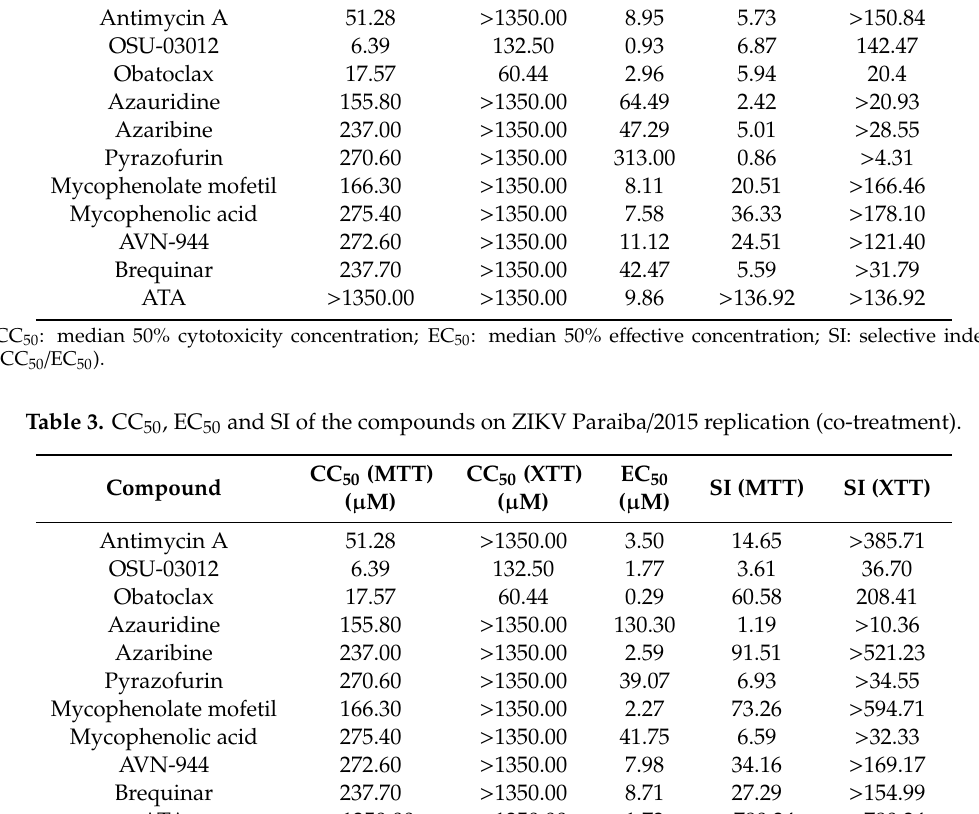
CC 50 (MTT) CC 50 (XTT) EC 50 SI (MTT) SI (XTT) ( µ M) ( µ M) ( µ M)